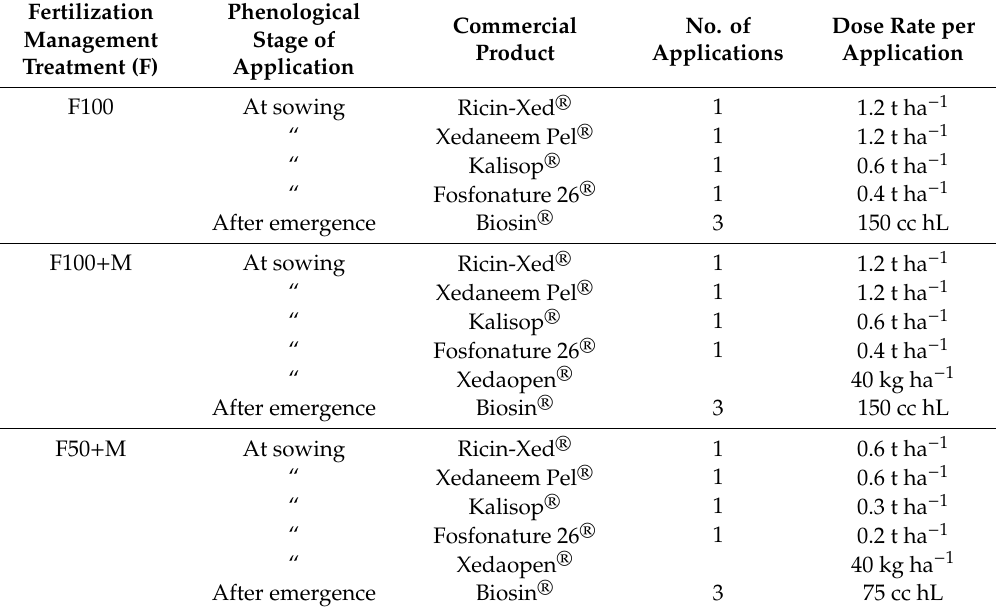
Table 2. Agronomic management treatments of ‘early’ crop potato under organic farming.